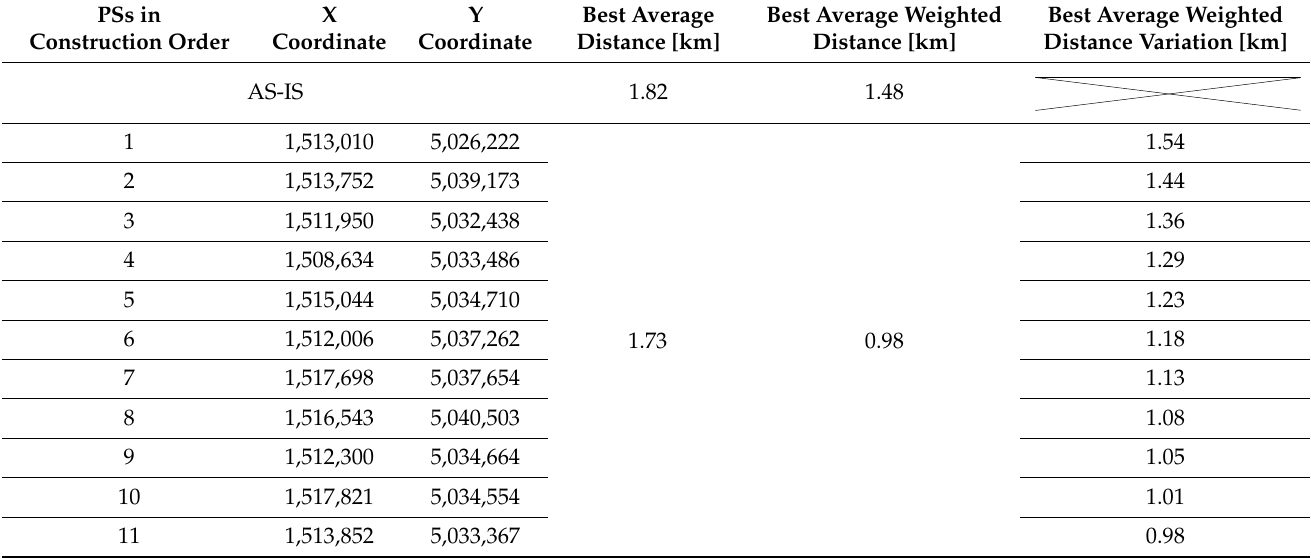
Table 6. Timing, siting of the new eleven PSs, and best average weighted distance values. Figure 14. Example of siting two new PSs among several others already in place. New PSs are in red